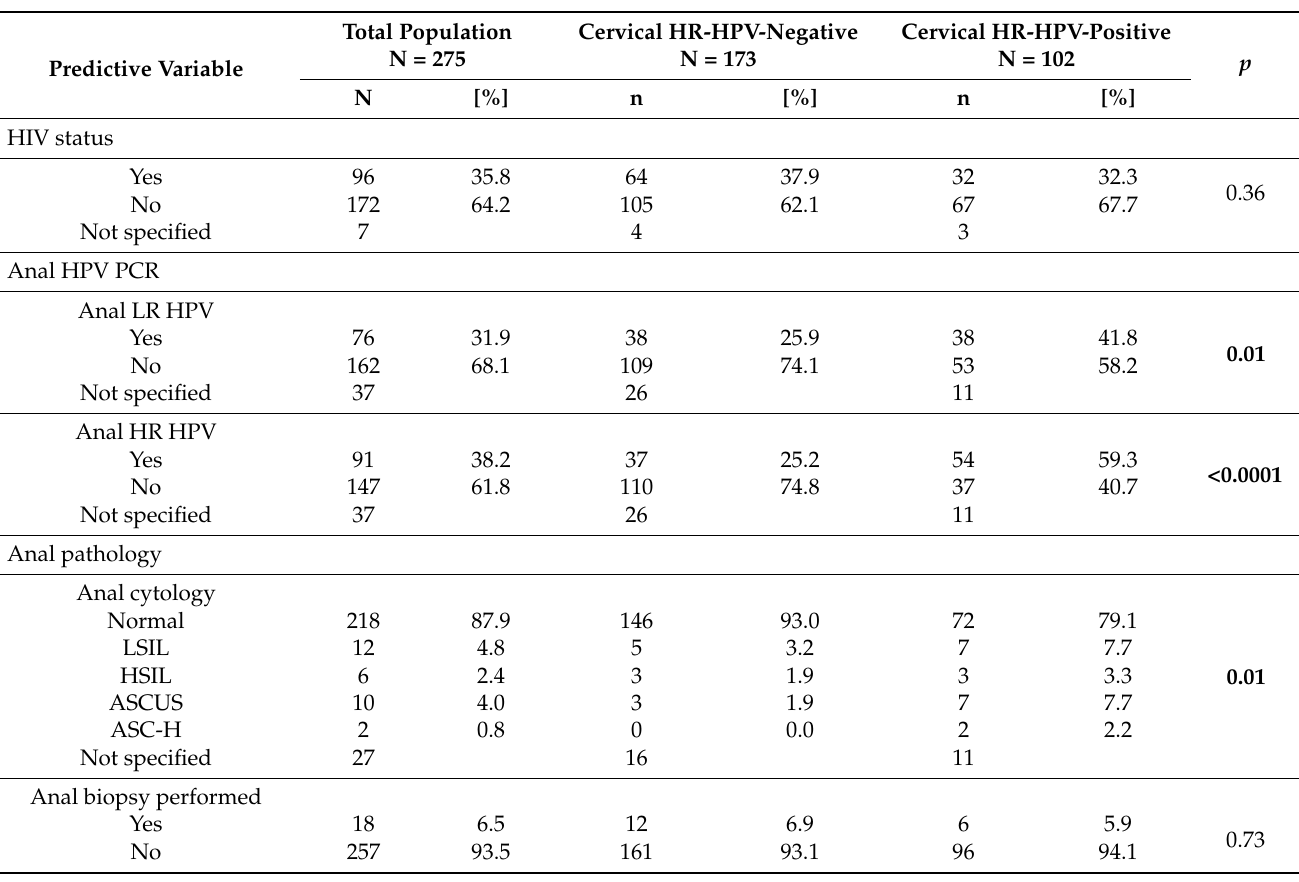
Table 2. Univariate analysis of cytopathologic factors associated with cervical HR-HPV: PCR geno- typing, cytology, pathology, and blood